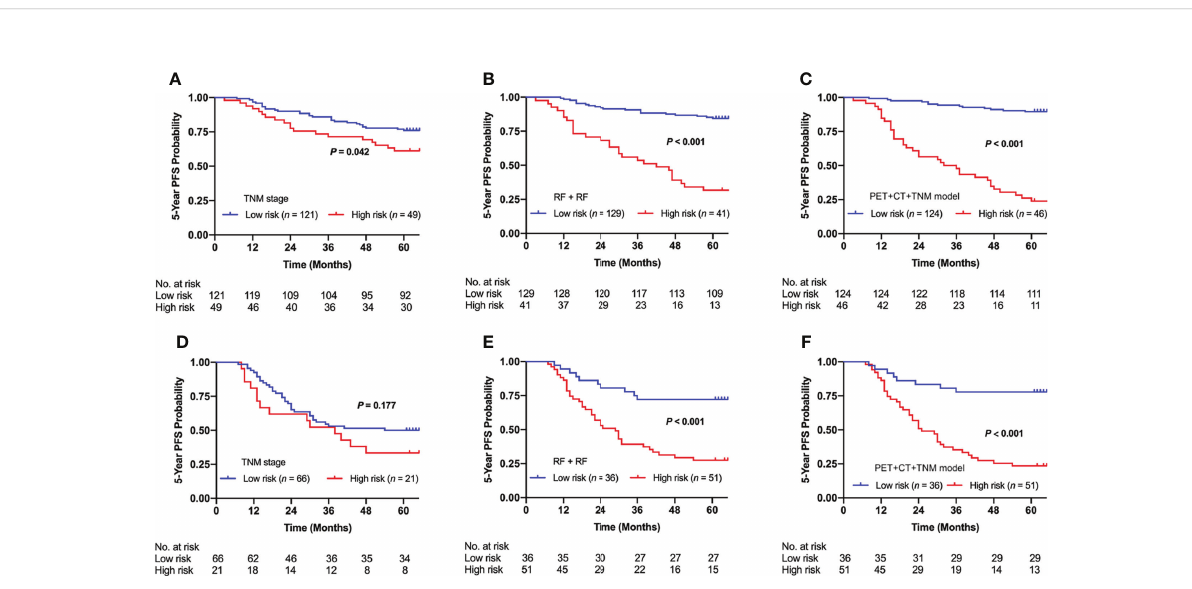
FIGURE 7 Kaplan – Meier curves of risk group strati fi cation based on clinical signature (TNM stage), conventional radiomics signature (RF + RF), and DLR signature (PET + CT + TNM model) on the internal cohort (A – C) and external cohort (D – F) . RF, Random Forest; DLR, deep learning-based